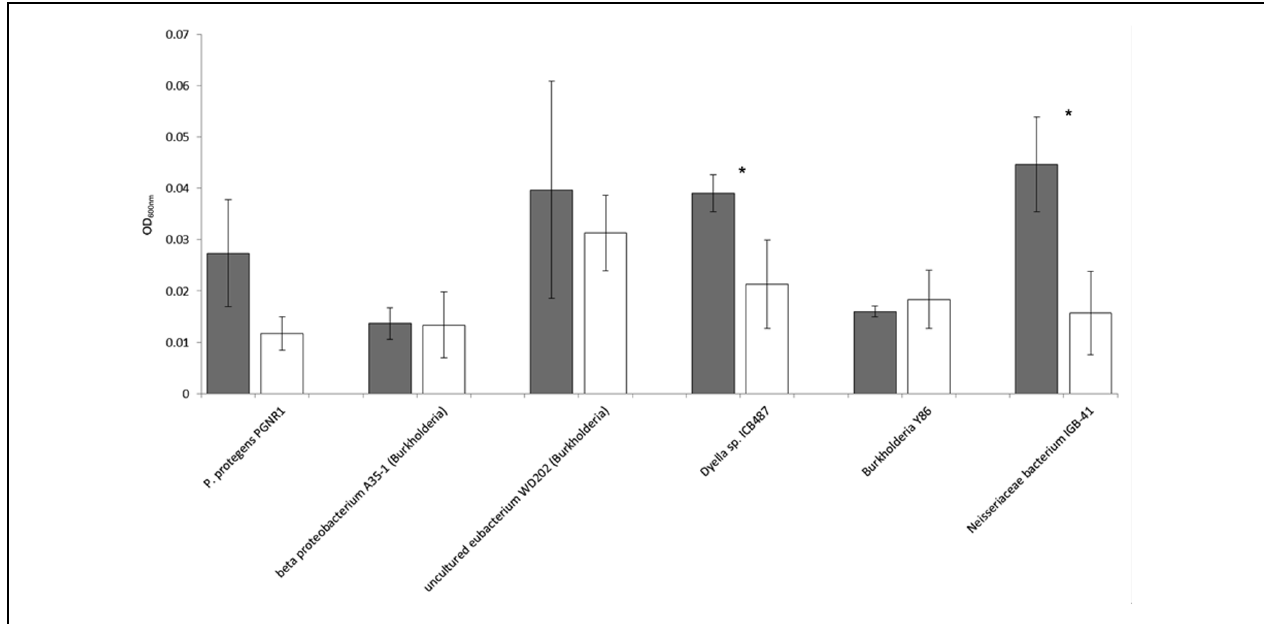
FIGURE 5 | Growth (OD 600nm ) of six potential mycophagous bacterial strains on liquid extracts obtained from intact fungal hyphae of the fungus M. hiemalis that had colonized Phytagel medium. Gray bars indicate growth on the control (liquid extract of Phytagel only), white bars growth on hyphal extracts. Error bars show standard deviations and stars indicate significant differences between control and treatment, resulting from a two-tailed t -test.